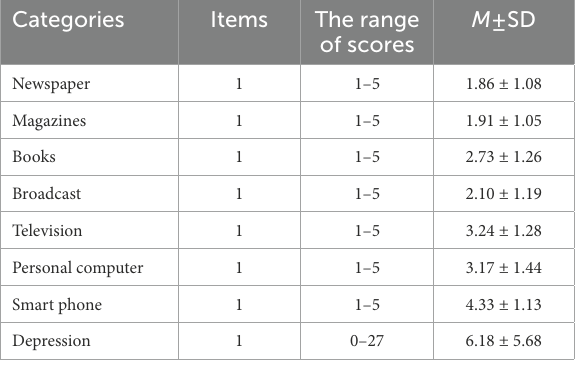
TABLE 3 The scores of media use and depression of the